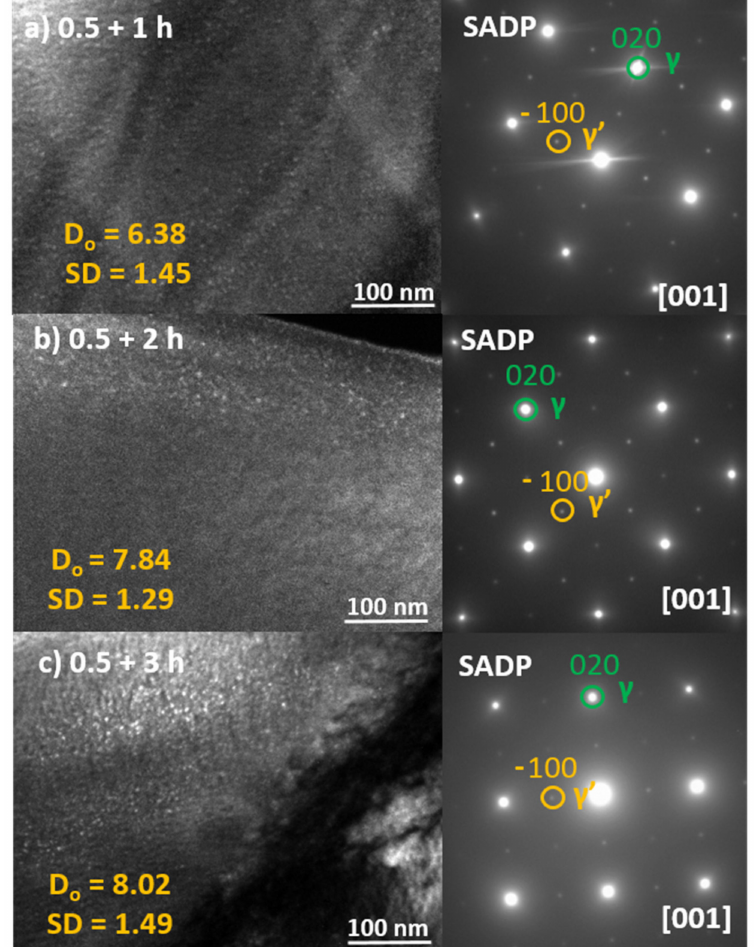
Figure 3. DF TEM microstructures and the corresponding selected area electron di ff raction patterns showing the γ ’ precipitates in the FeNiCoAlTa single crystal aged at 973 K and for 1, 2 and 3 h at 723 K. D o —average precipitate diameter (nm), SD—standard deviation of precipitate diameter